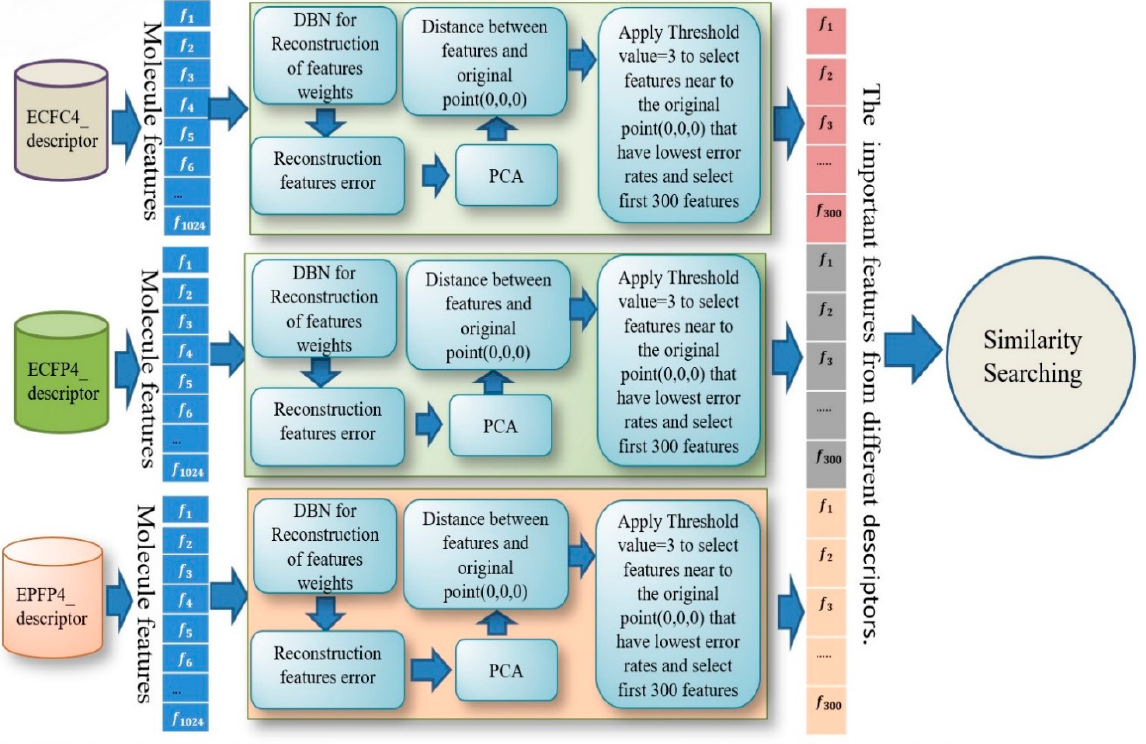
Figure 3. Combine multi descriptors based on SDBN.